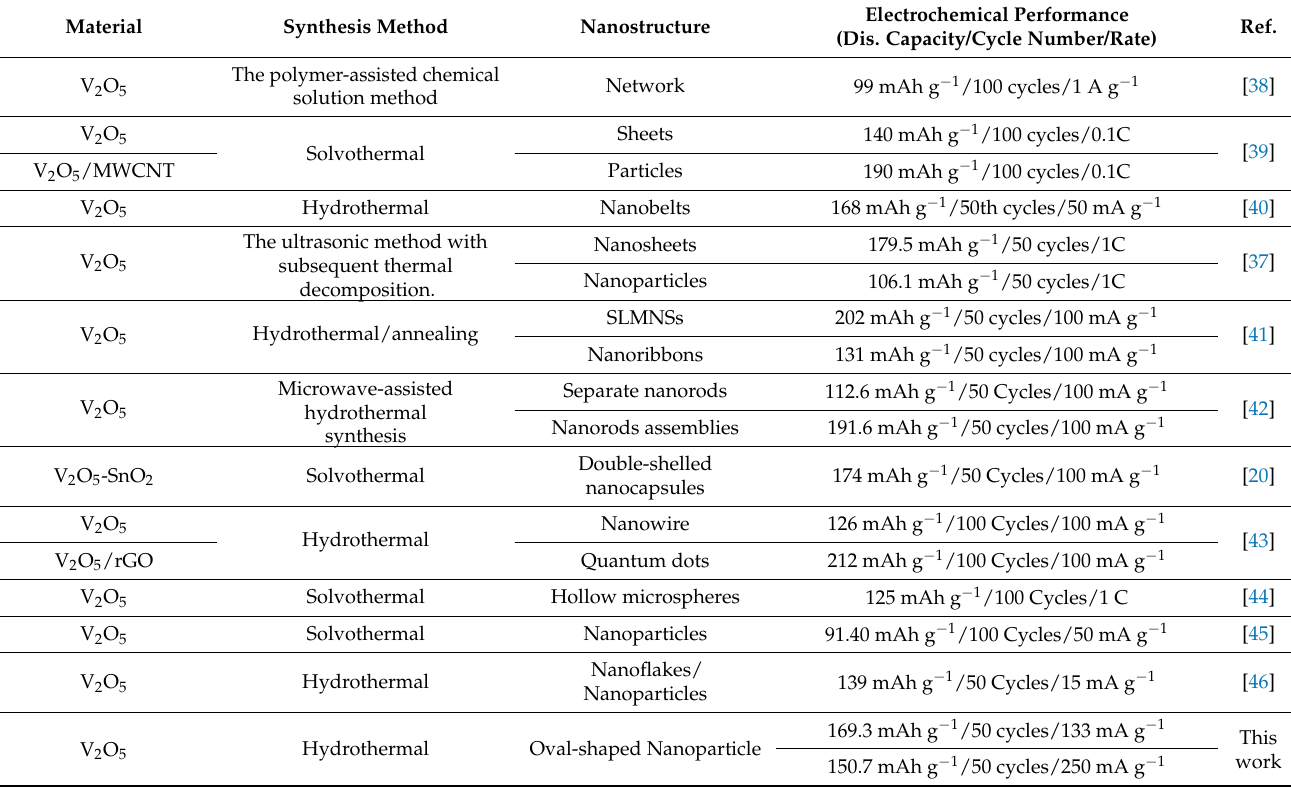
Table 1. Electrochemical performance comparison between the current oval-shaped V 2 O 5 nanopar- ticle electrode and the previously reported pure and composite V 2 O 5 electrode materials based on numerous